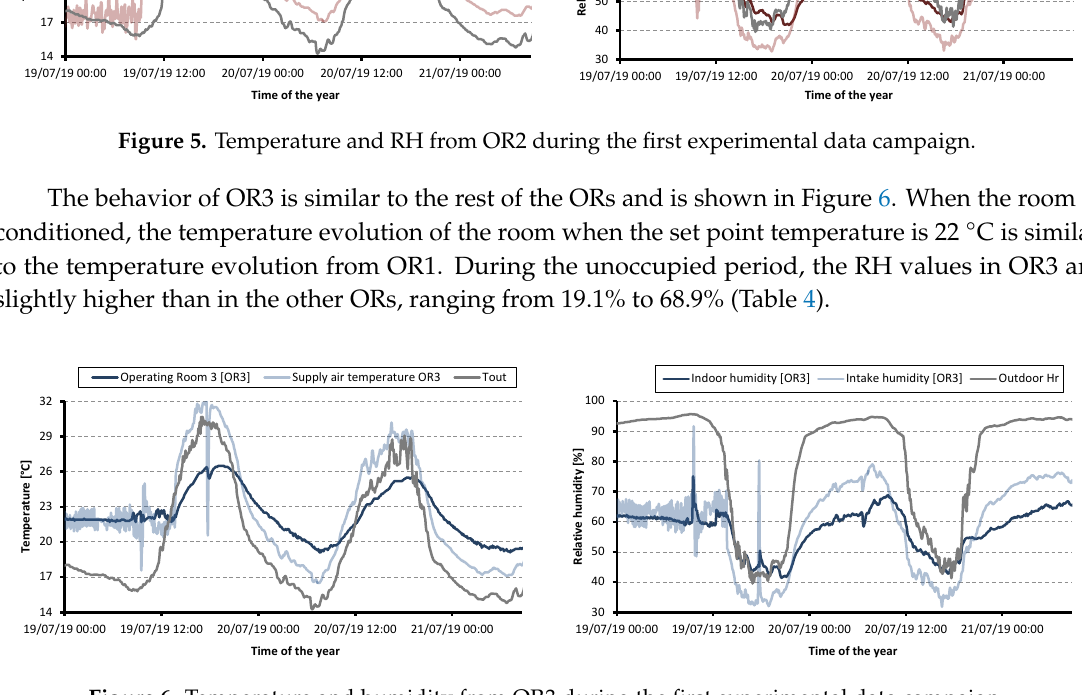
Table 4. Maximum, minimum and average temperature and humidity from the ORs. OR1 OR2 OR3